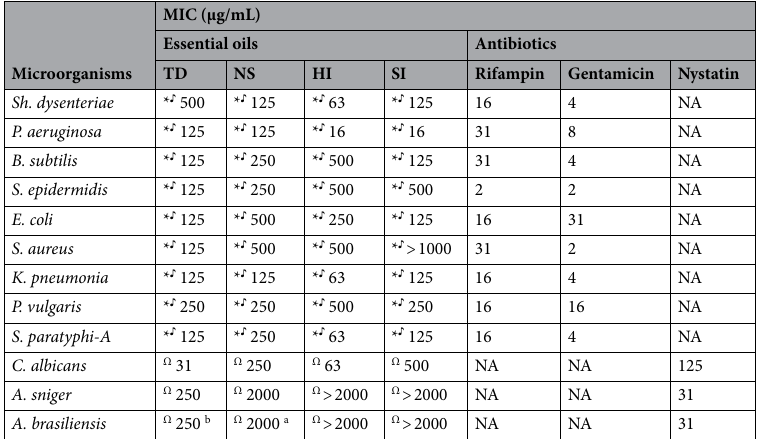
Table 3. MIC obtained using antibiotics (used as references) and the essential oils from Thymus daenensis (TD), Nepeta sessilifolia (NS), Hymenocrater incanus (HI), and Stachys inflata (SI) . Symbols (*) indicate values statistically different from rifampin, symbols ( ♪ ) indicate values statistically different from gentamicin and symbols (Ω) indicate values statistically different from nystatin (p <